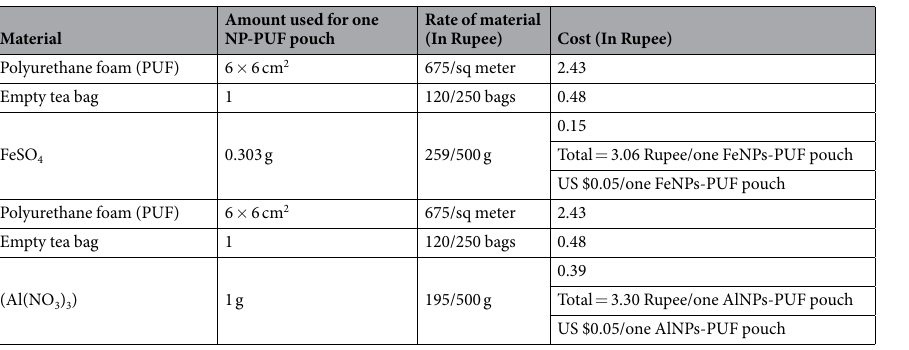
Rate of material (In Rupee) Cost (In Rupee)